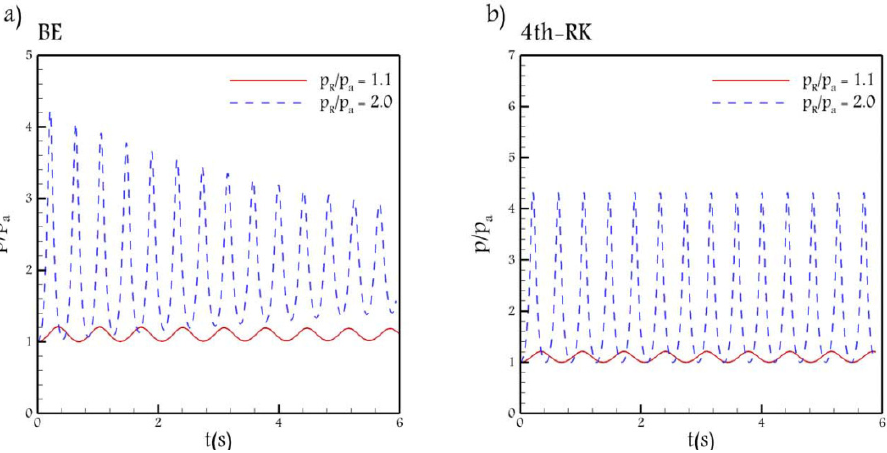
Figure 3. The non-dimensional air absolute pressure (p p (cid:2911) ⁄ ) distribution vs. the time, calculated by classical 4th order Runge–Kutta scheme, for the reservoir pressure ratio (p (cid:2902) p (cid:2911) ⁄ ) of 2.0, and ( a ) different air initial lengths, ( b ) different water initial lengths.